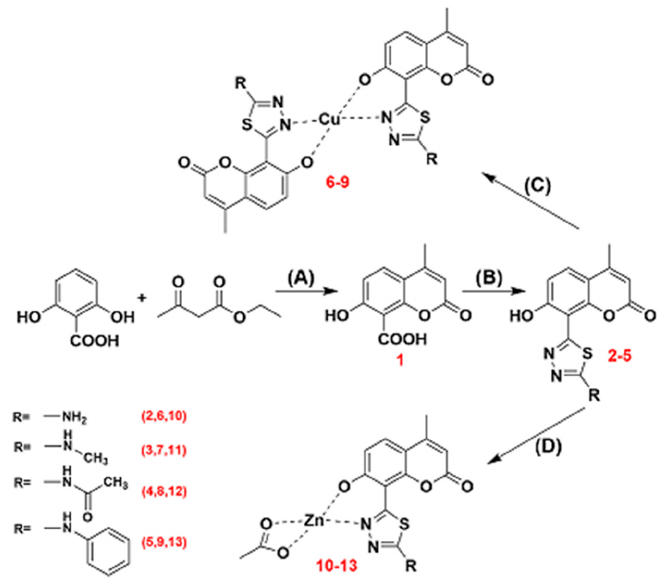
Figure 1. Synthetic pathway for the synthesis of coumarin-thiadiazole hybrids ( 2 – 5 ) and their cor- responding Cu(II) and Zn(II) complexes 6 – 13 : ( A ) H 2 SO 4 , 25 °C; ( B ) POCl 3 , thiosemicarbazide, 75 °C; ( C ) Cu(CH 3 COO) 2 xH 2 O, EtOH/H 2 O, reflux; ( D ) Zn(CH 3 COO) 2 xH 2 O, EtOH/H 2 O, reflux. For clarity, the aqua ligands in the complexes were omitted from the above figure.